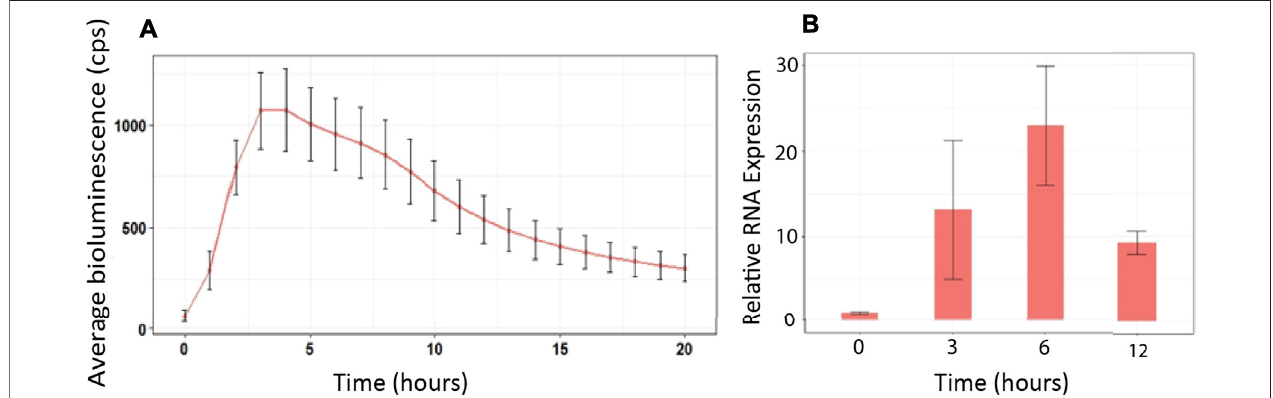
FIGURE 1 | GSTF7:luc expression mimics endogenous GSTF7 expression following H 2 O 2 treatment. (A) Four-day-old GSTF7:luc seedlings were treated with 1 mM H 2 O 2 for 40 min, and the bioluminescence was measured over 20 h using a CCD camera. The average light units from 20 seedlings at each hour, with standard errors, are presented. (B) RNA samples were extracted before treatment (time (cid:1) 0), 3, 6, and 12 h following 1 mM H 2 O 2 treatments. Expression levels of GSTF7 were determined by qPCR. Illustrated are normalized expression levels to cyclophilin (At2g29960). Average was calculated out of 3 biological